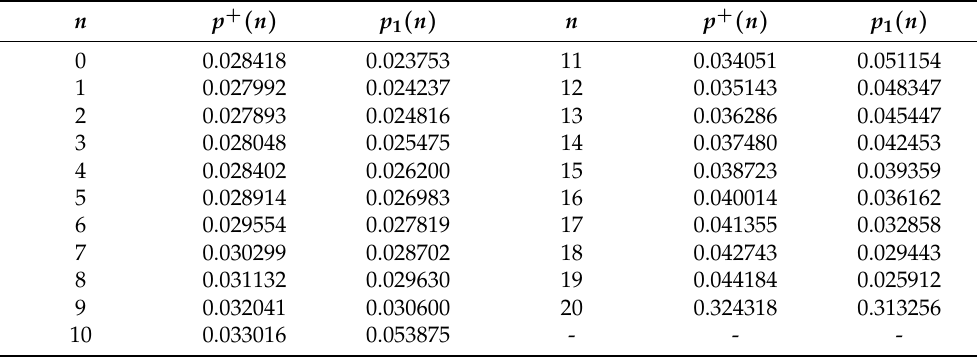
Table 1. Computation of post-departure epoch probabilities and random epoch probabilities (when the server is busy) for Example 1 with the parameters λ = 20, µ = 1.619870, a = 3, b = 10, N = 20 and ρ =